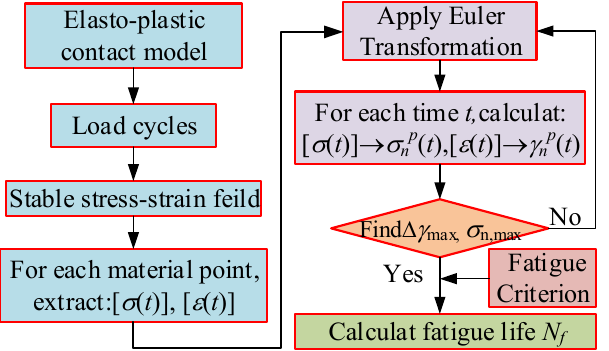
Figure 17. Computational methodology of predicting fatigue life.